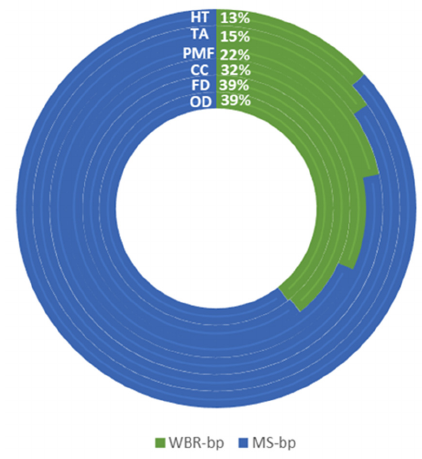
Figure 9. Relative contribution to the studied environmental categories of MS and WBR based